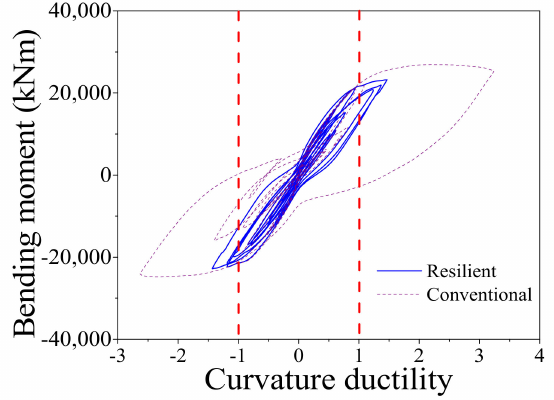
Figure 17. Bending moment vs. curvature ductility.